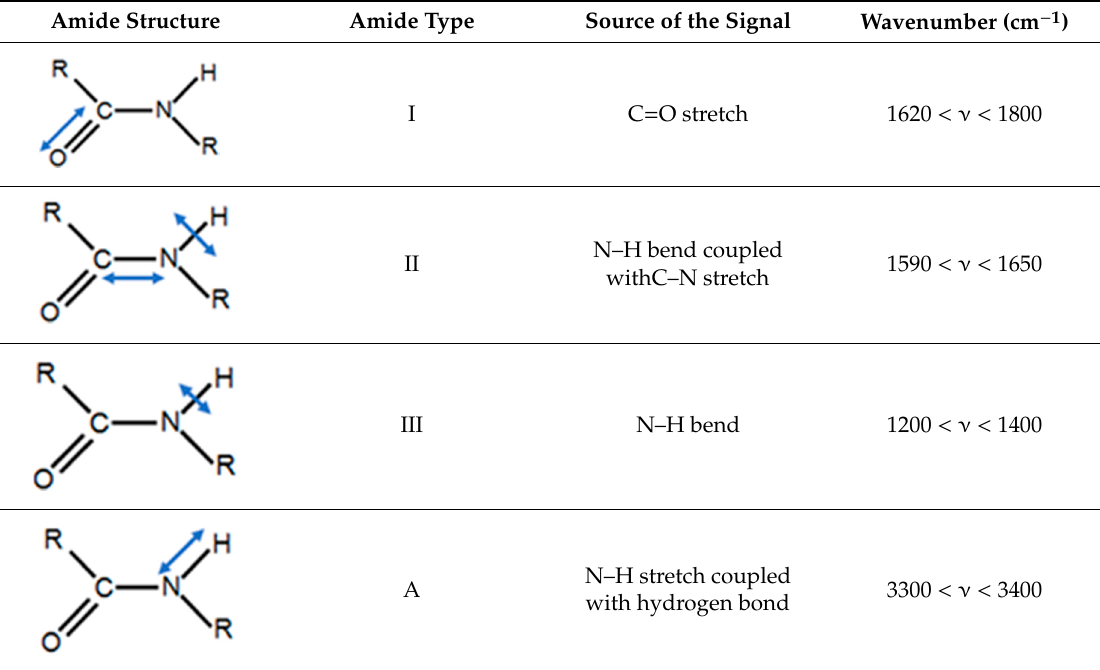
Table 4. Functional groups present in collagen type I.